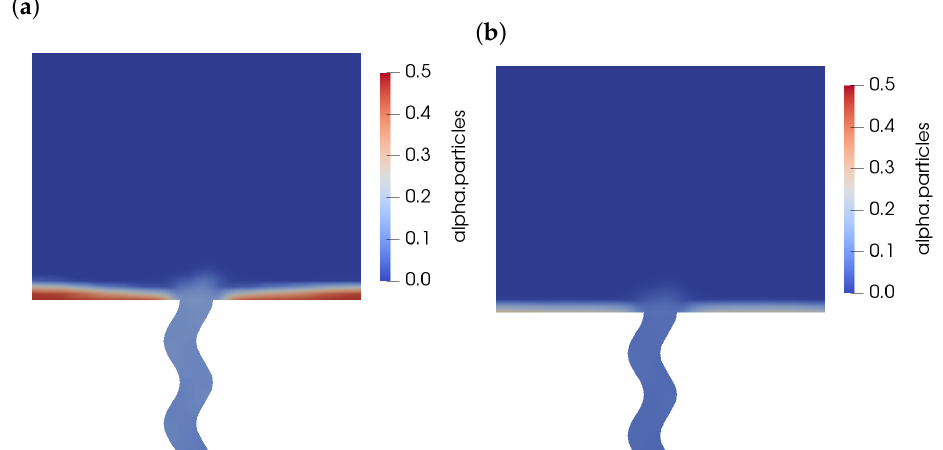
Figure 11. Effect of manipulation sequence and vibration on the volume fraction field. ( a ) W = 1mm at t = 5s, f = 20Hz, a = 1.25mm, no manipulation. ( b ) W = 1mm at t = 5s, f = 20Hz, a = 1.25mm, θ = 10 ◦ , ω =